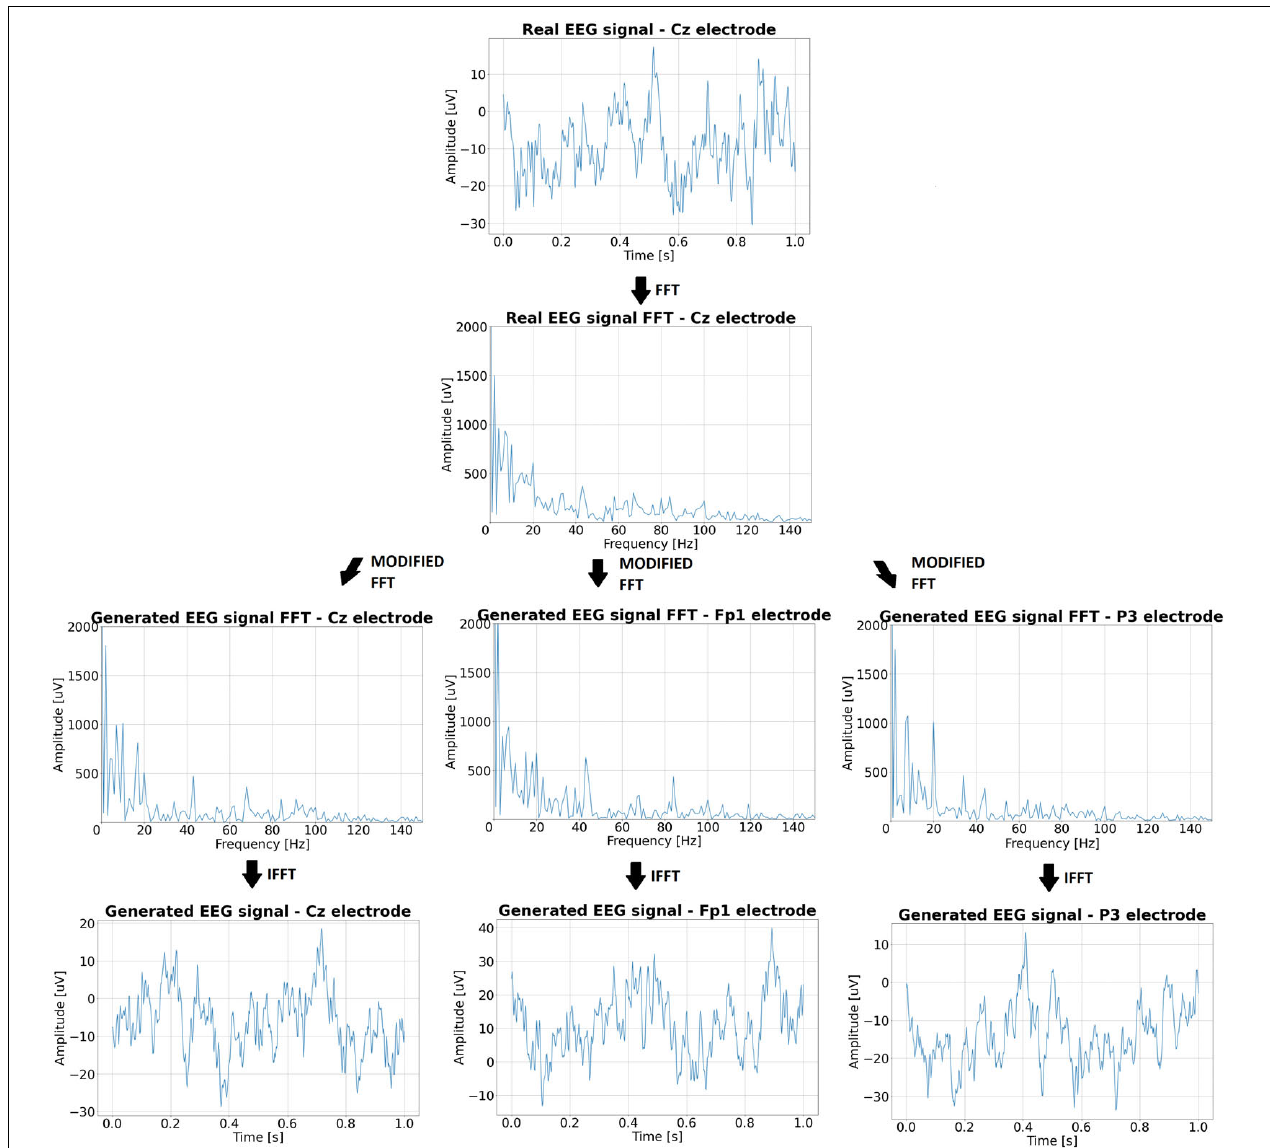
FIGURE 5 | The real EEG signal from the Cz electrode, its spectrum, and the artificial signals generated on its basis along with the